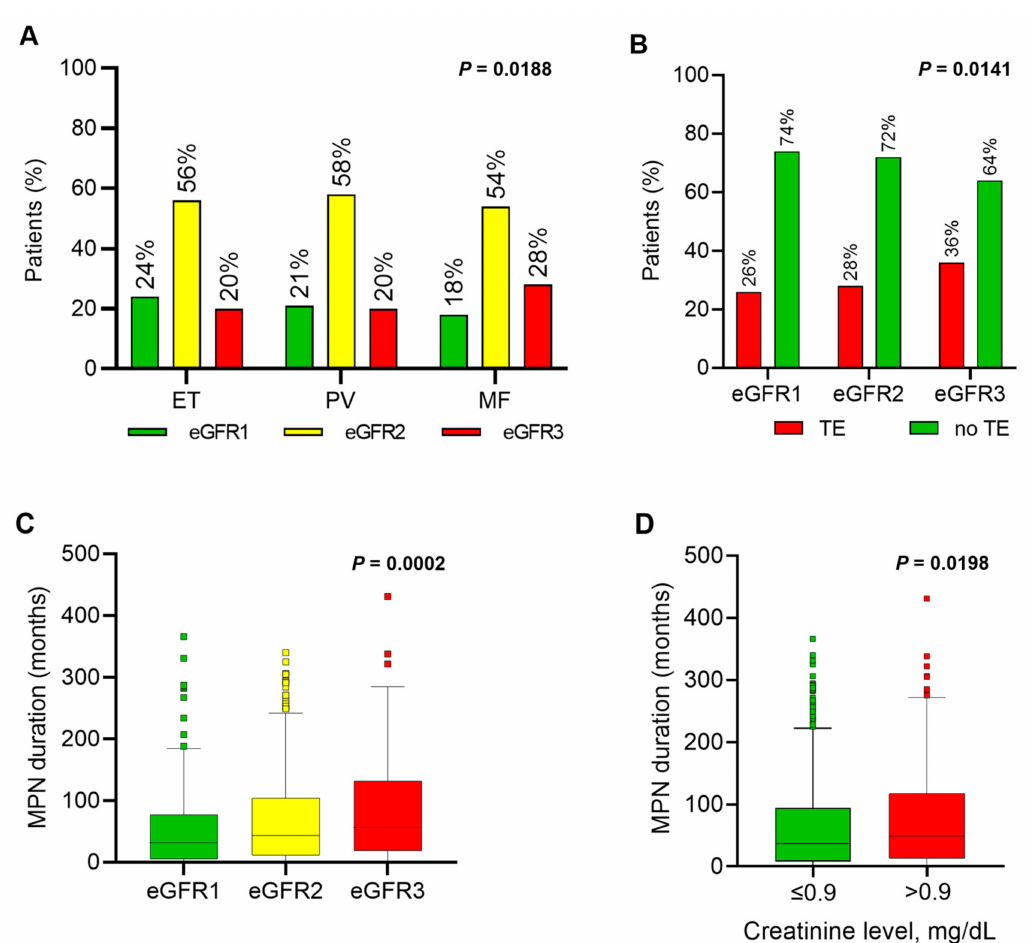
Figure 1. Distribution of kidney dysfunction, thrombosis, and MPN duration across all patients (pts; n = 1420). ( A ) Dis- tribution (%) of kidney function groups eGFR1 ( ≥ 90 mL/min/1.73 m 2 ), eGFR2 (60–89 mL/min/1.73 m 2 ), or eGFR3 (<60 mL/min/1.73 m 2 ) across the MPN subtypes ET, PV, and MF; ( B ) Percentage of pts with (yes) or without (no) a history of thromboembolic events (“thrombosis”) among the eGFR1,2,3 groups; ( C ) MPN duration in months from diagnosis to renal function assessment in the eGFR1,2,3 groups. In addition, median MPN duration is indicated for each eGFR group; ( D ) MPN duration in months from diagnosis to renal function assessment in the group of patients with a creatinine level at or below the median ( ≤ 0.9 mg/dL) or above the median (>0.9 mg/dL). In addition, median MPN duration is indicated for both groups. * Wilcoxon–Mann–Whitney